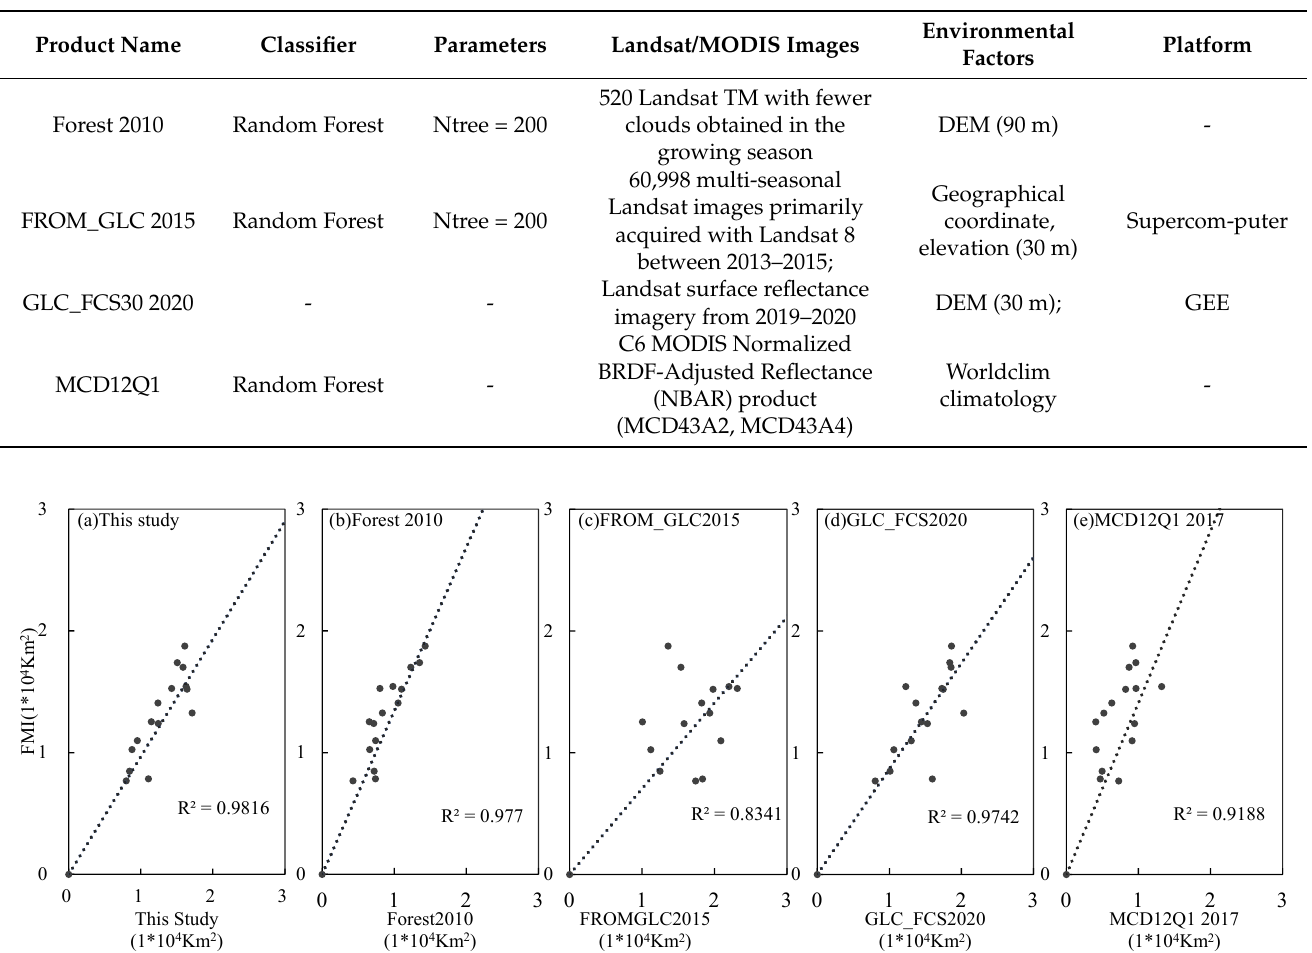
Table 12. Comparisons of four public products.